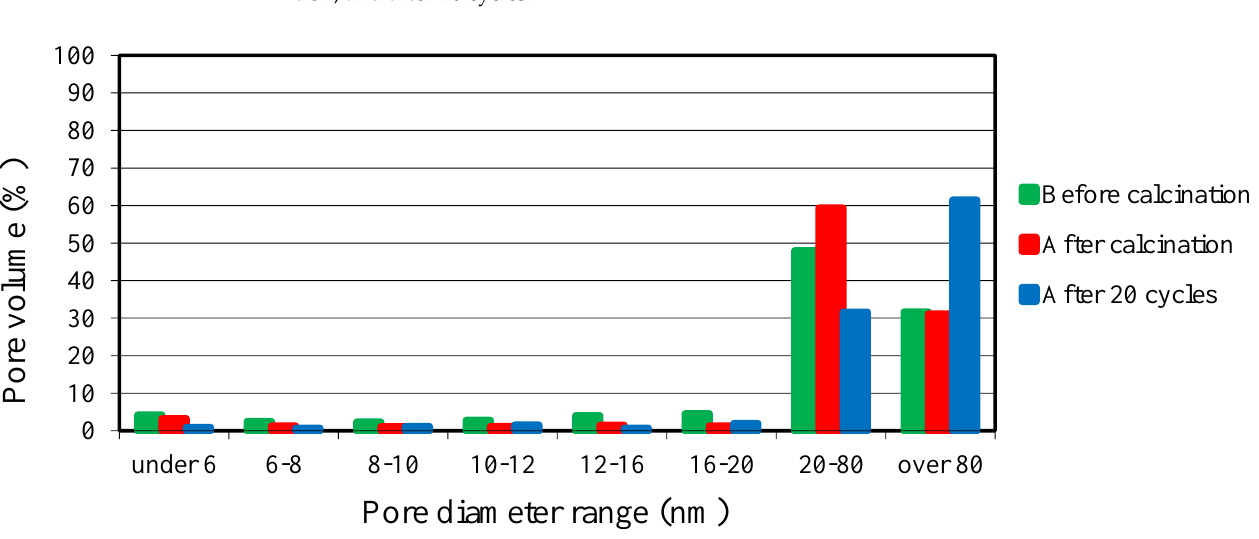
Figure 7. A comparison of Tetín limestone pore size distribution before calcination, after calcina- tion, and after 20 cycles. Comparing sample results in Figures 4 – 7, it can be seen that the most prominent structural changes were in the mesopores and macropores. The only exception that demonstrated negligible changes was the Tetín sample, which was also the sample with the lowest and highest CaO and MgO content, respectively. The biggest structural changes were observed in the Libotín and Branžovy samples. In Figure 4 it can be ob- served that the pore size of the Libotín sample after calcination corresponded to the pore